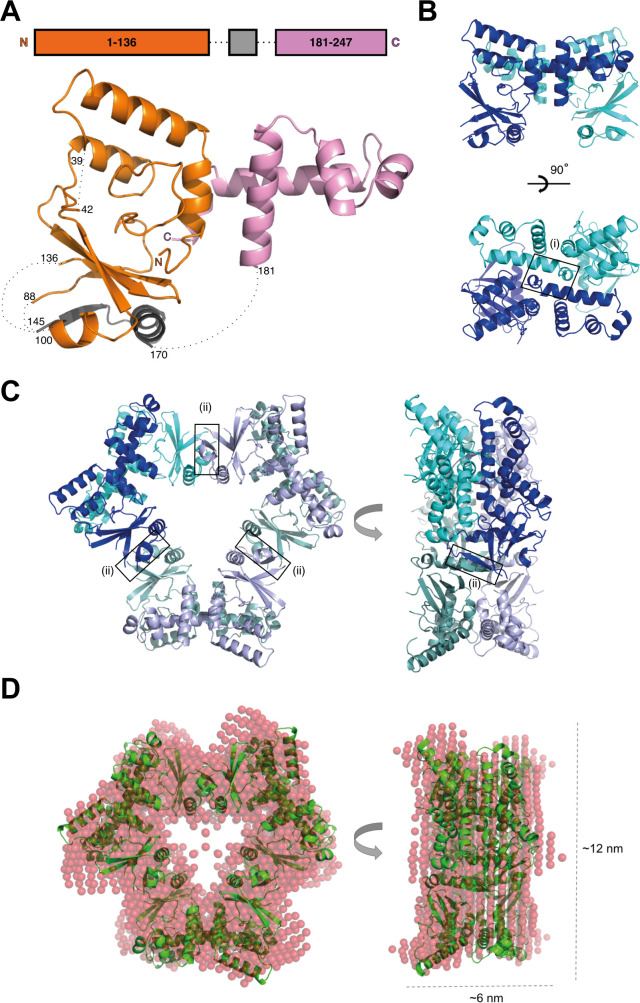
RovC forms a hexameric ring-shaped protein.(A) Crystal structure of RovC with domain boundaries (top) and cartoon representation of RovC (below). The N-terminal domain is illustrated in orange and gray, and the C-terminal domain in pink. An elongated stretch of amino acids (gray) folds into a secondary structure, which we can confidently assign to the central region (aa 137–180) of RovC. An unambiguous assignment of individual amino acids to this section was however not possible due to ill-defined electron density. This stretch has been assigned to position 145–170 based on secondary structure prediction. Flexible/unstructured loops are shown as black dotted lines. (B) Structure of the RovC dimer subunit in two orientations. The two protomers are shown in blue and cyan. The box depicts the position of the mutant A237E/G242E in interface (i). (C) Hexameric ring of RovC in two orientations. The hexameric ring has been generated by applying crystallographic symmetry on the monomeric RovC structure and is composed of three RovC dimers (colors of one dimer as in B, the other two RovC dimers are shown in darker tones of blue and green). The boxes depict the position of the mutants I150P and I150P/Y151P in interface (ii). (D) SAXS modelling. Individual ab initio model derived from DAMMIN (red spheres) spatially superimposed with the hexameric RovC-ring derived from the X-ray crystal structure (green). Orientations are as in C.